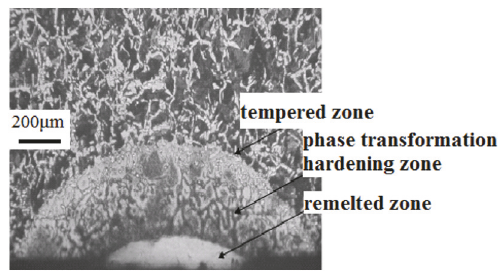
Figure 3: Laser melting area micrograph at view of 400 x metallo- graphic microscope 200 𝜇 m.